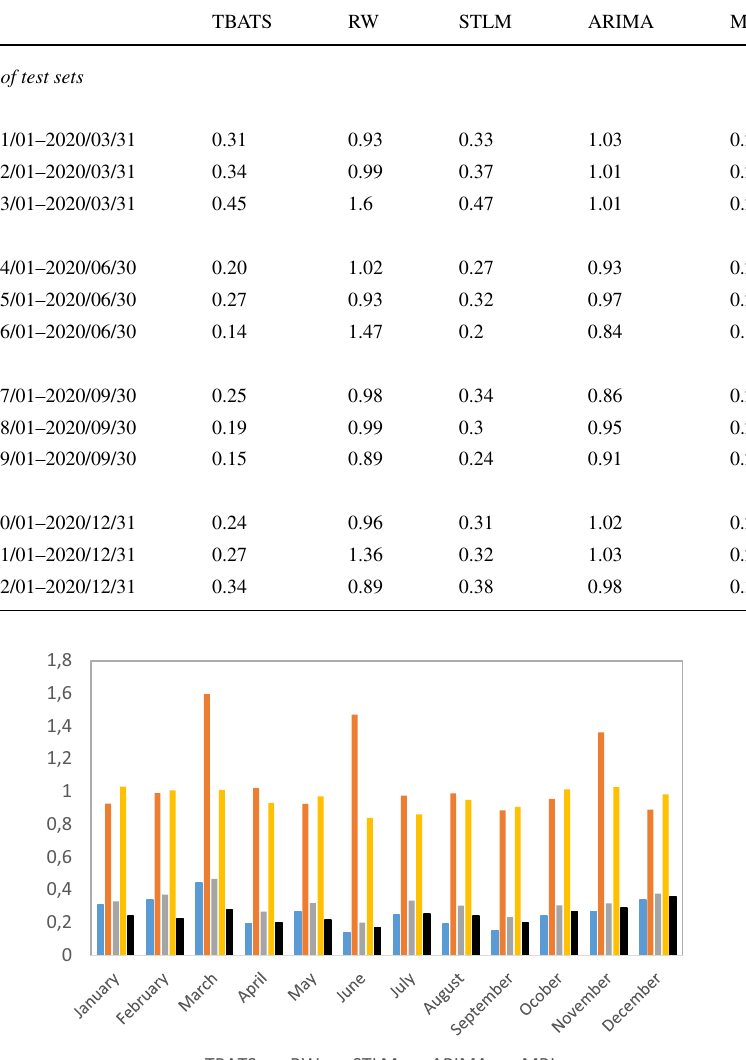
Table 4 Rolling forecast scheme month by month until the end of the quarter Forecast horizon